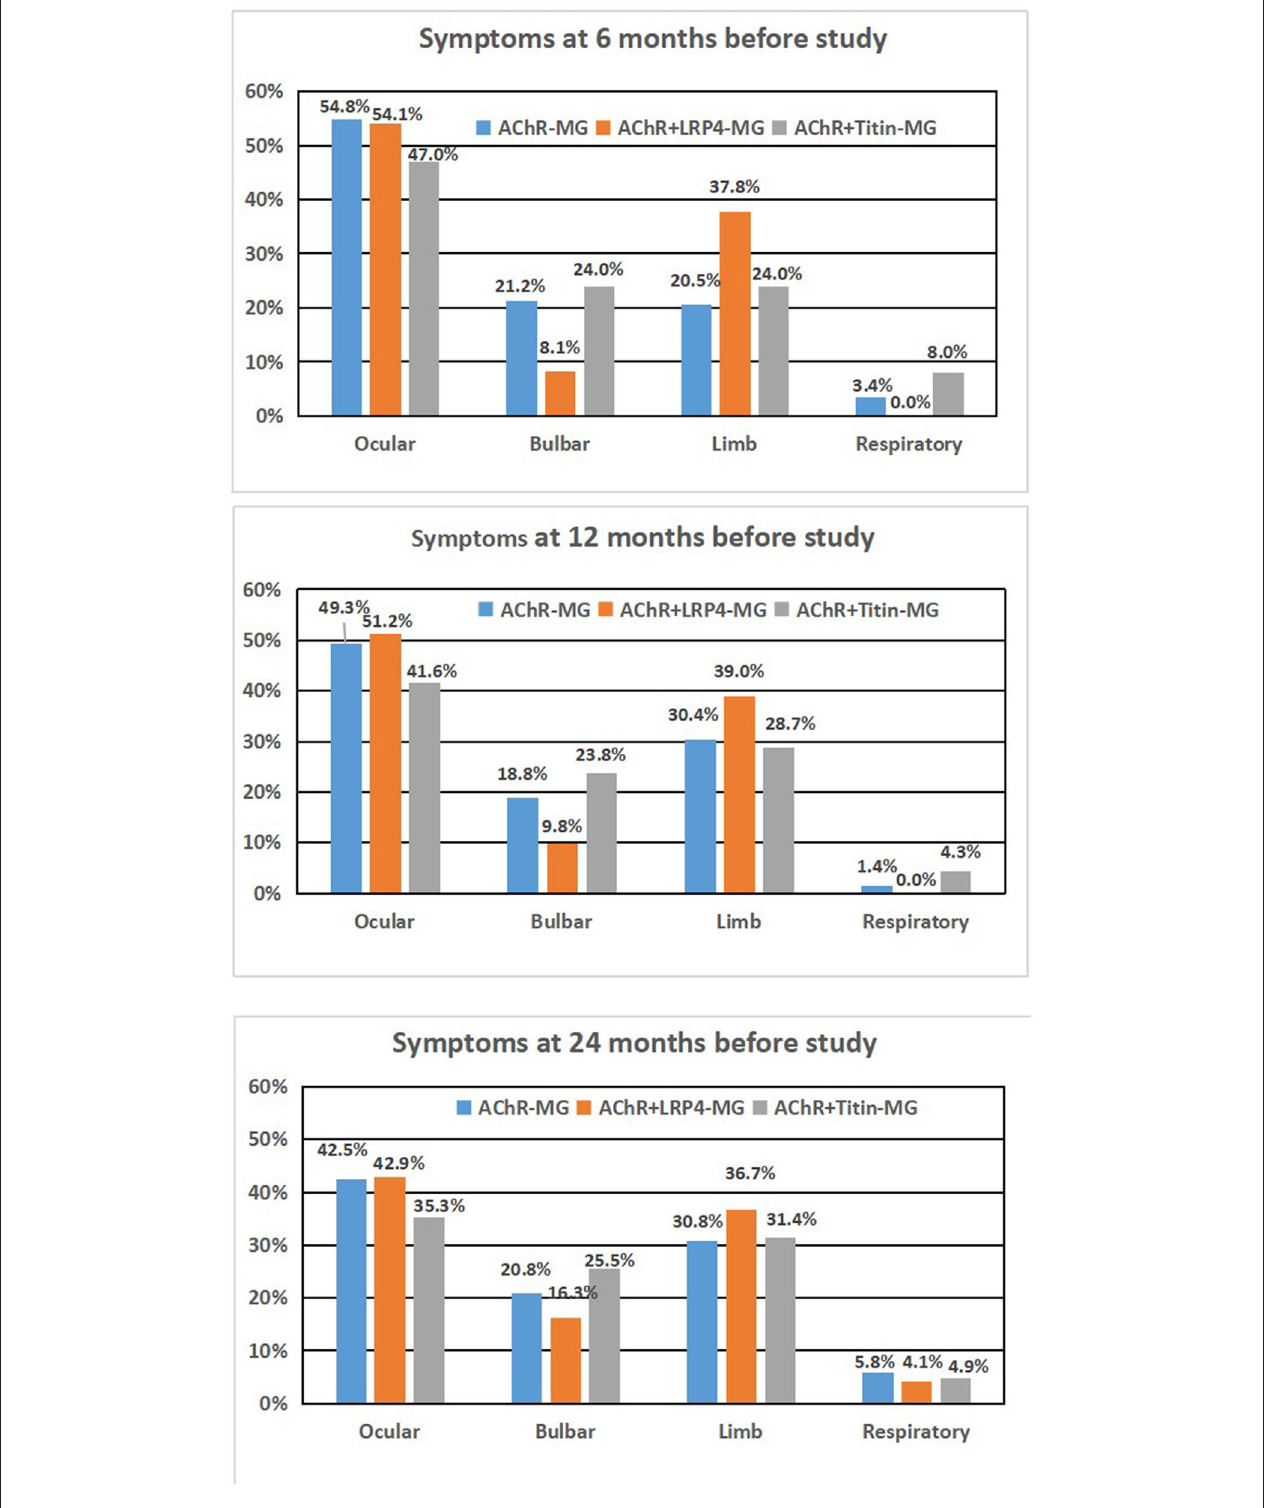
FIGURE 2 | Syptoms of AChR-MG, AChR + LRP4-MG, and AChR + Titan-MG patients during different time period. (A) 6 months before study, (B) 12 months before study, and (C) 24 months before study.